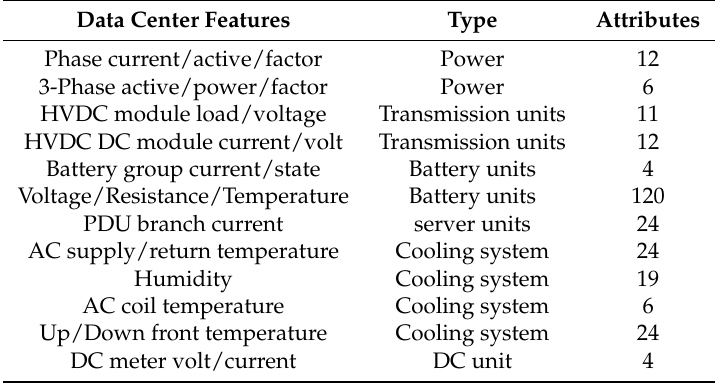
Table 1. Data center’s data set with all 470,226 feature